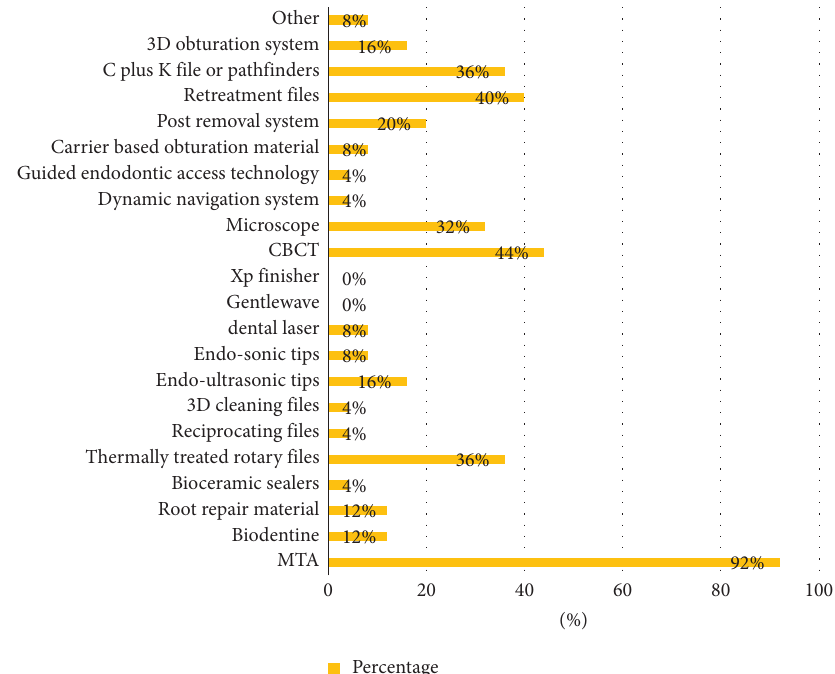
Figure 1: Distribution of the materials and equipment available for dental students’ use in dental schools of Saudi